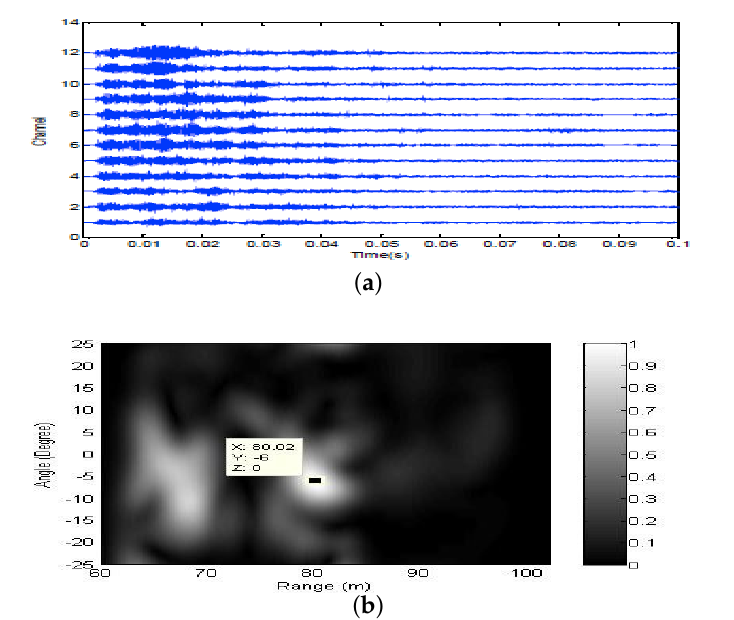
Figure 15. PCW signals: ( a ) the enhanced echoes received by the 14-element horizontal array; ( b ) the ambiguity surface of the output of the distributed TR-MIMO sonar system.